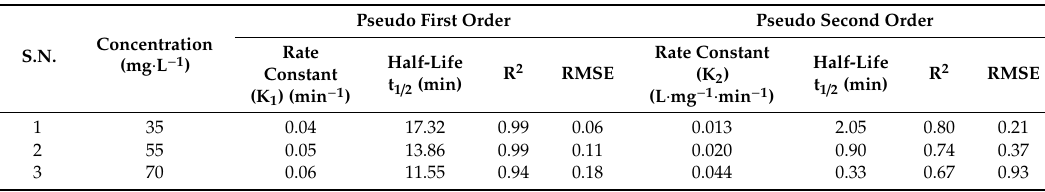
Figure 10. ( a ) Linear regression plot of pseudo first-order fit and ( b ) pseudo second-order fit at 35, 55, and 70 mg · L − 1 MG concentrations using 20 mg catalyst, pH 8, 5–90-min irradiation time and 6.35 W mL − 1 ultrasonic power. Table 2. Pseudo first- and second-order kinetic parameters for photodegradation of malachite green by chitosan-ascorbic acid@NiFe 2 O 4 for 35, 55, and 70 mg · L − 1 MG degradation at pH 8 for a time irradiation range of 5–90 min at 25 ◦ C.